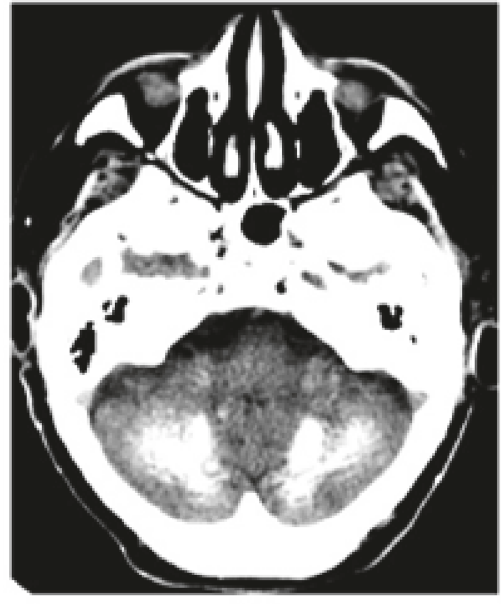
Figure 2: Cerebellar calcifications (CT scan).